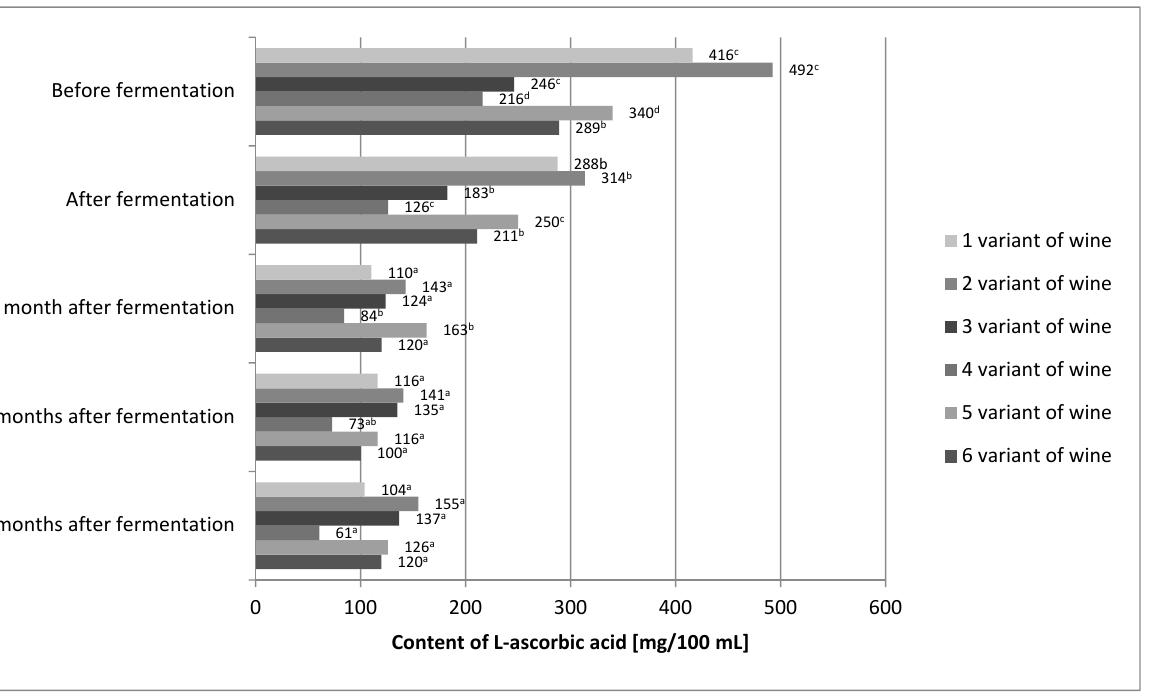
Figure 2. The content of L-ascorbic acid in variants of the prepared wine from fruits of Rosa rugosa . The values with different superscript letters are significantly different ( p < 0.05). Table 3. Multivariate analysis of variance of the L-ascorbic acid content in wines after 3 months of aging on the share of fruit (a), fermentation in must or pulp (b), enzymatic treatment or its absence (c), and a combination of factors a * b and a * c.